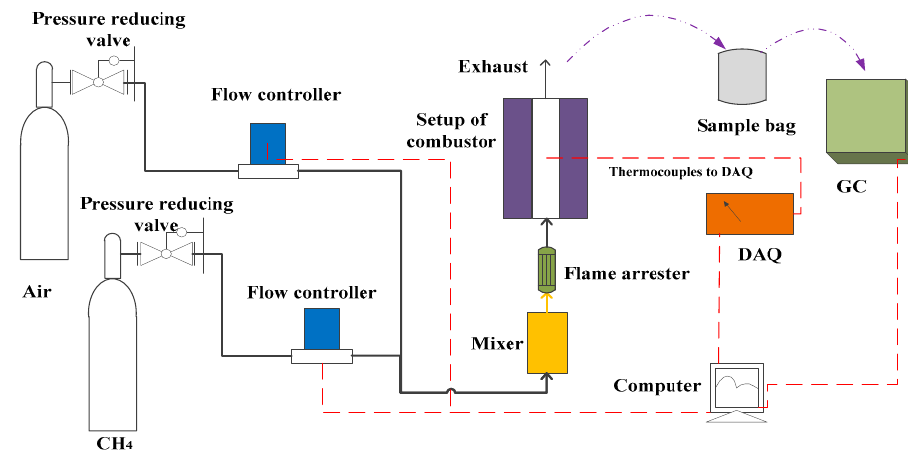
Figure 12. The schematic diagram of the experiment setup.